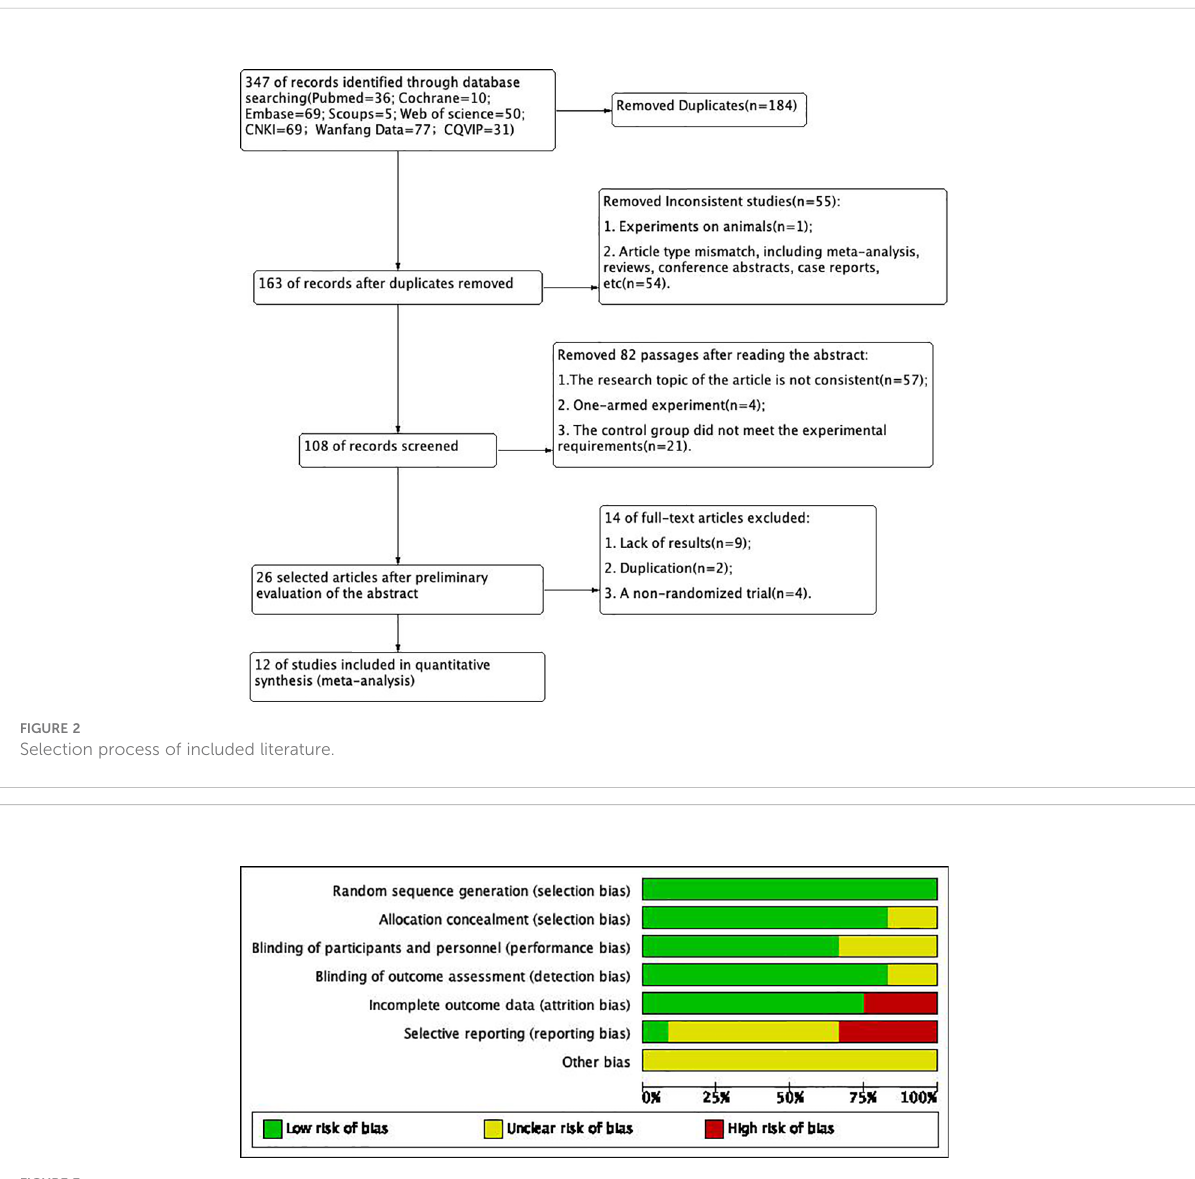
FIGURE 3 The evaluation results of article quality were